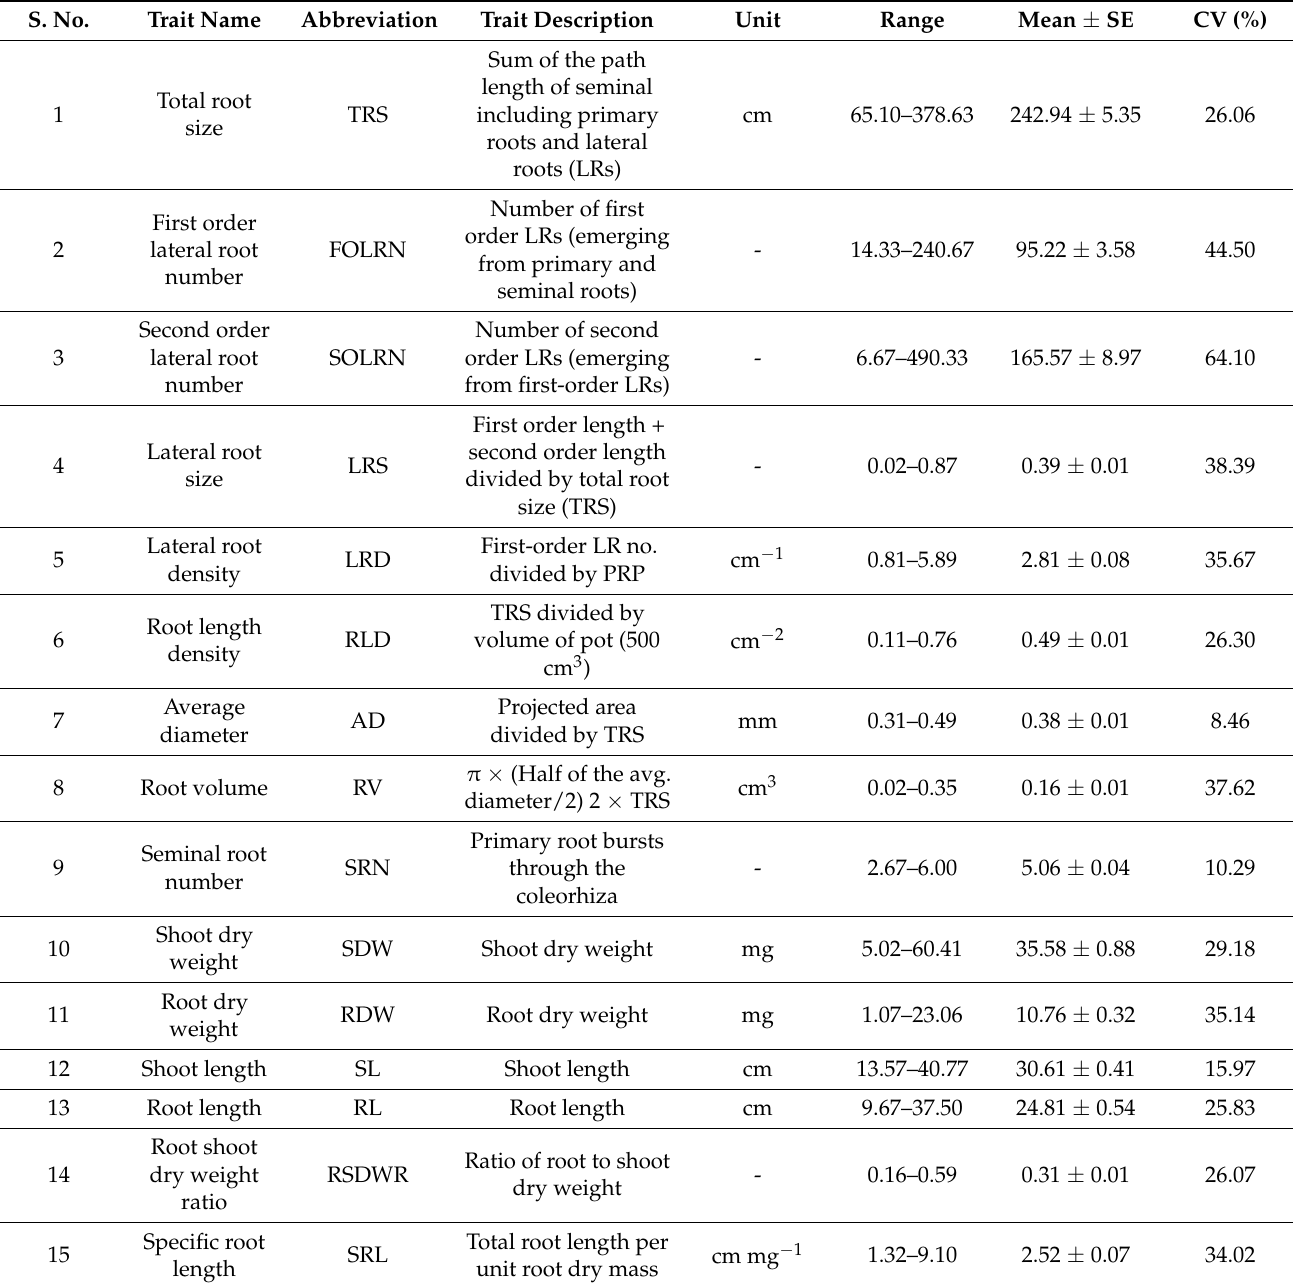
Table 1. Root system architecture and shoot traits along with their basic statistics of the wheat accessions in the diverse association